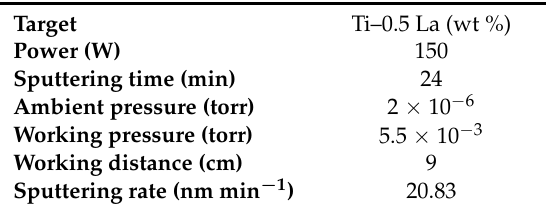
Table 1. The parameters of sputtering in present